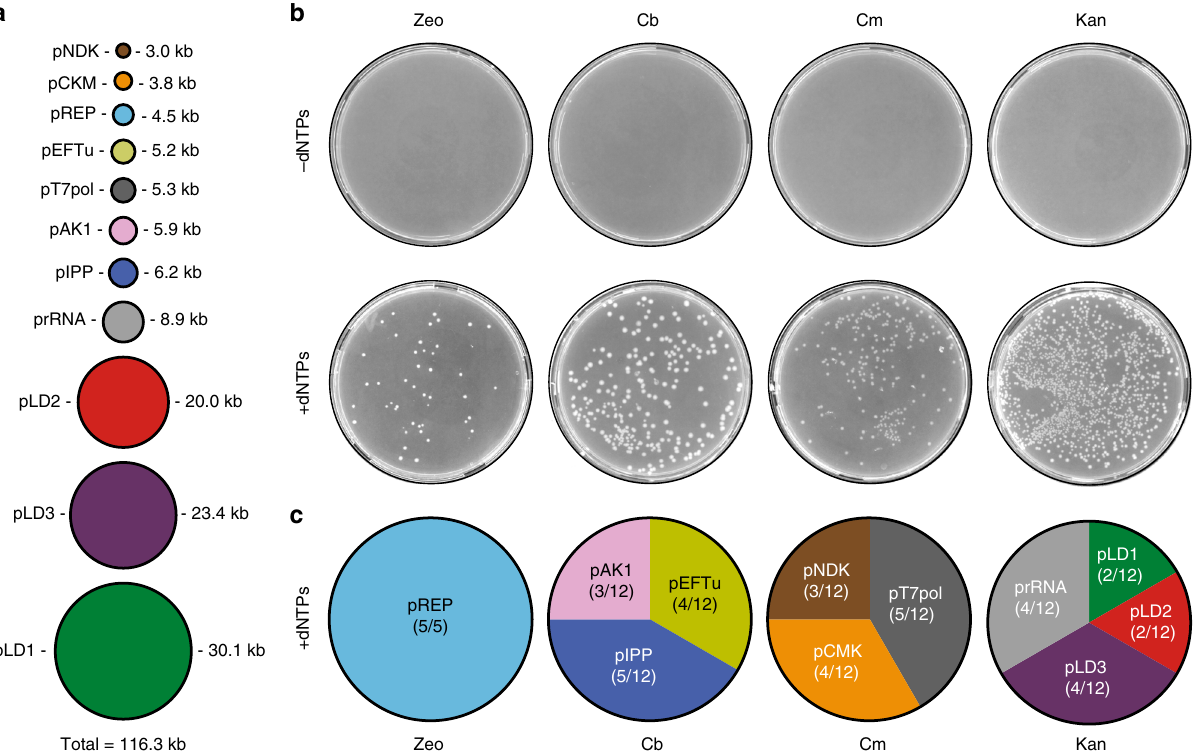
Fig. 3 In vitro replication of a 116.3 kb multipartite DNA genome. a The collection of 11 plasmids (combined length 116.3 kb), which were co-replicated in PURErep. In addition to Phi29-DNAP (pREP, 6 nM input), the plasmid ensemble encodes the ribosomal rRNA operon rrnB (prRNA, 3 nM input), all E. coli TFs (pLD1-3, pEFTu, 0.6 nM input each), a minimal NTP regeneration system (pNDK, pCKM, pAK1, 3 nM input each), T7-RNA polymerase (pT7pol, 3 nM input) and inorganic pyrophosphatase (pIPP, 3 nM input). b LB plates of E. coli 10-beta cells transformed with overnight TTcDR reactions containing all